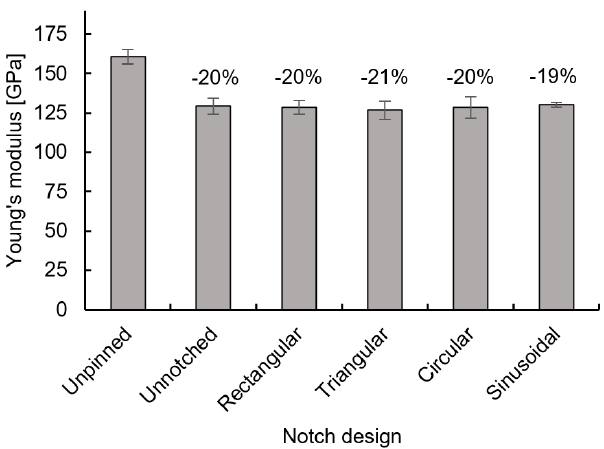
Figure 10. Average values of tensile modulus and standard deviation of unidirectional carbon-fibre/ epoxy laminates reinforced with unnotched z-pins as well as with circumferentially notched z-pins with different notch designs at constant notch depth of 20 µ m and notch distance of 100 µ m, in relation to the unpinned